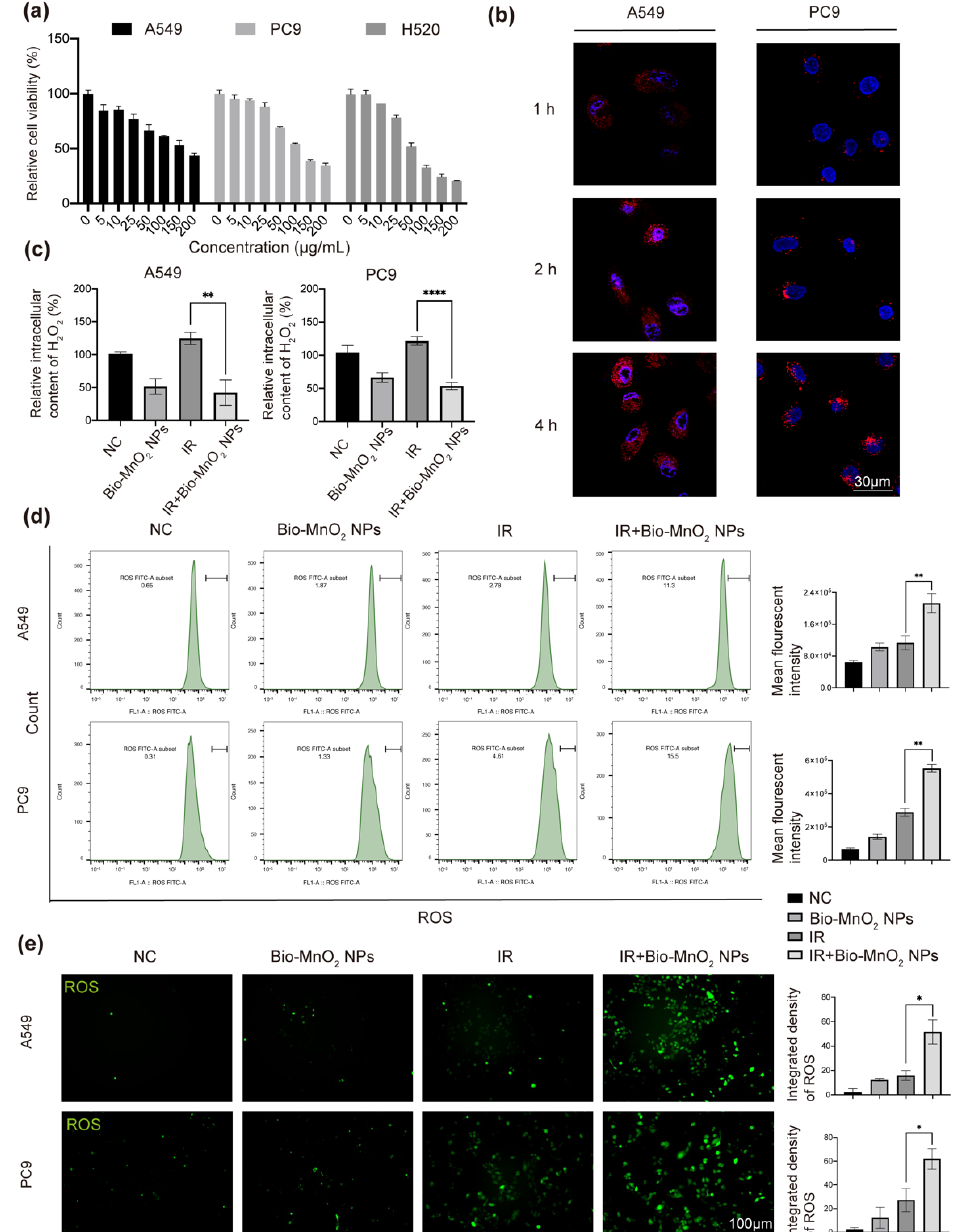
Figure 2. Bio-MnO 2 NPs eliminated H 2 O 2 and enhanced reactive oxide species (ROS) production in non-small cell lung cancer (NSCLC) cells. ( a ) Cell viabilities of A549, PC9 and H520 cells treated with different concentrations of Bio-MnO 2 NPs for 24 h. ( b ) Uptake of Cy3 labelled Bio-MnO 2 NPs at different time intervals (1 h, 2 h, 4 h). Scale bar, 30 µ m. ( c ) Relative intracellular H 2 O 2 content after incubation with Bio-MnO 2 NPs (25 µ g/mL) for 4 h with or without irradiation (IR) (8 Gy). ( d ) Flow cytometry of ROS probe in NSCLC cells after different treatments as above. ( e ) Representative DCF staining images of NSCLC cells. Scale bar, 100 µ m. The combination of Bio-MnO 2 NPs and IR significantly enhanced ROS production than individual treatment. *, p < 0.05; **, p < 0.01; ****, p <